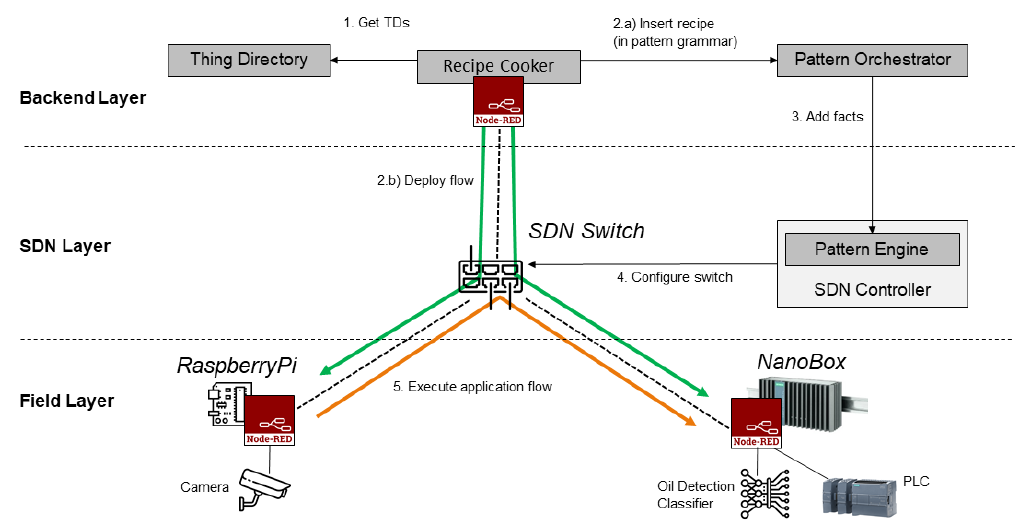
Figure 8. Setup of the oil leakage detection application.